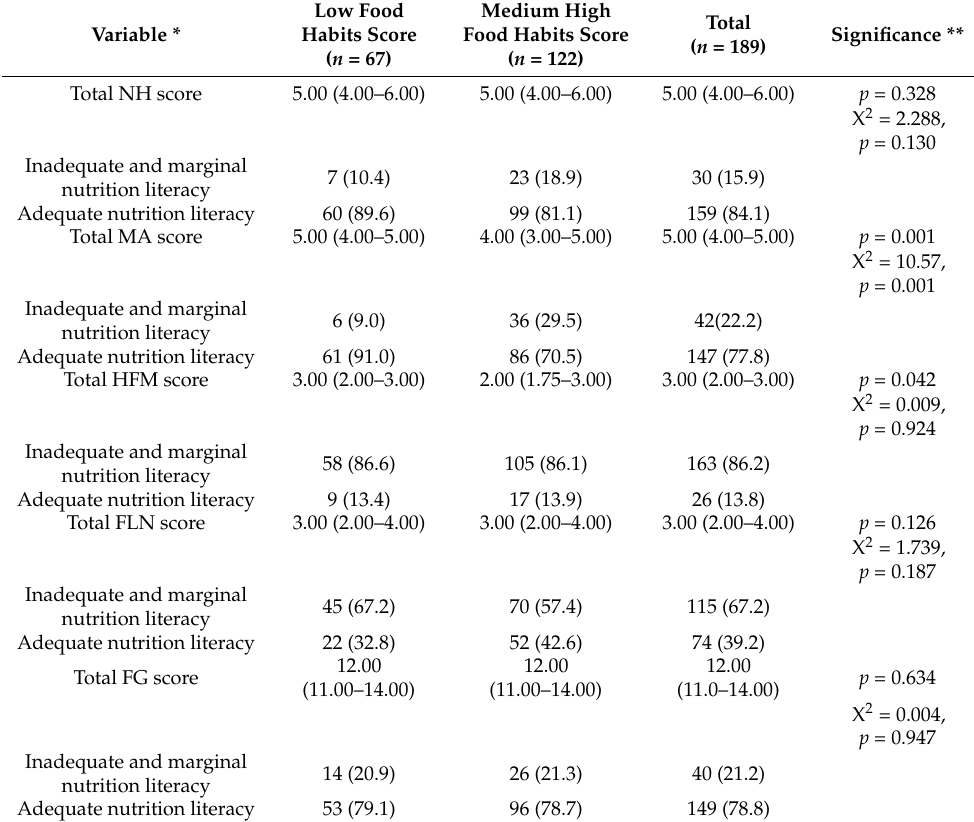
Table 6. Mean nutrition literacy score by food habits score category ( n = 189) }